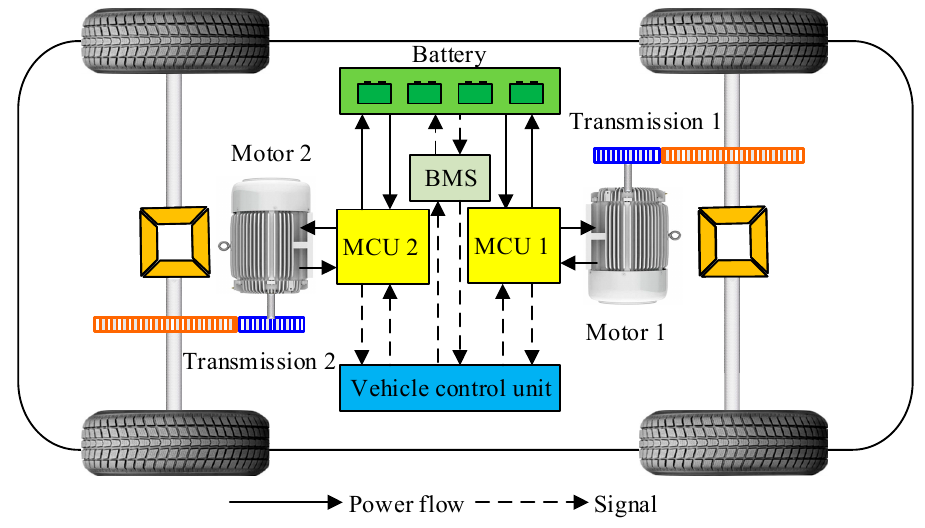
Figure 2. Layout of electric drive system.